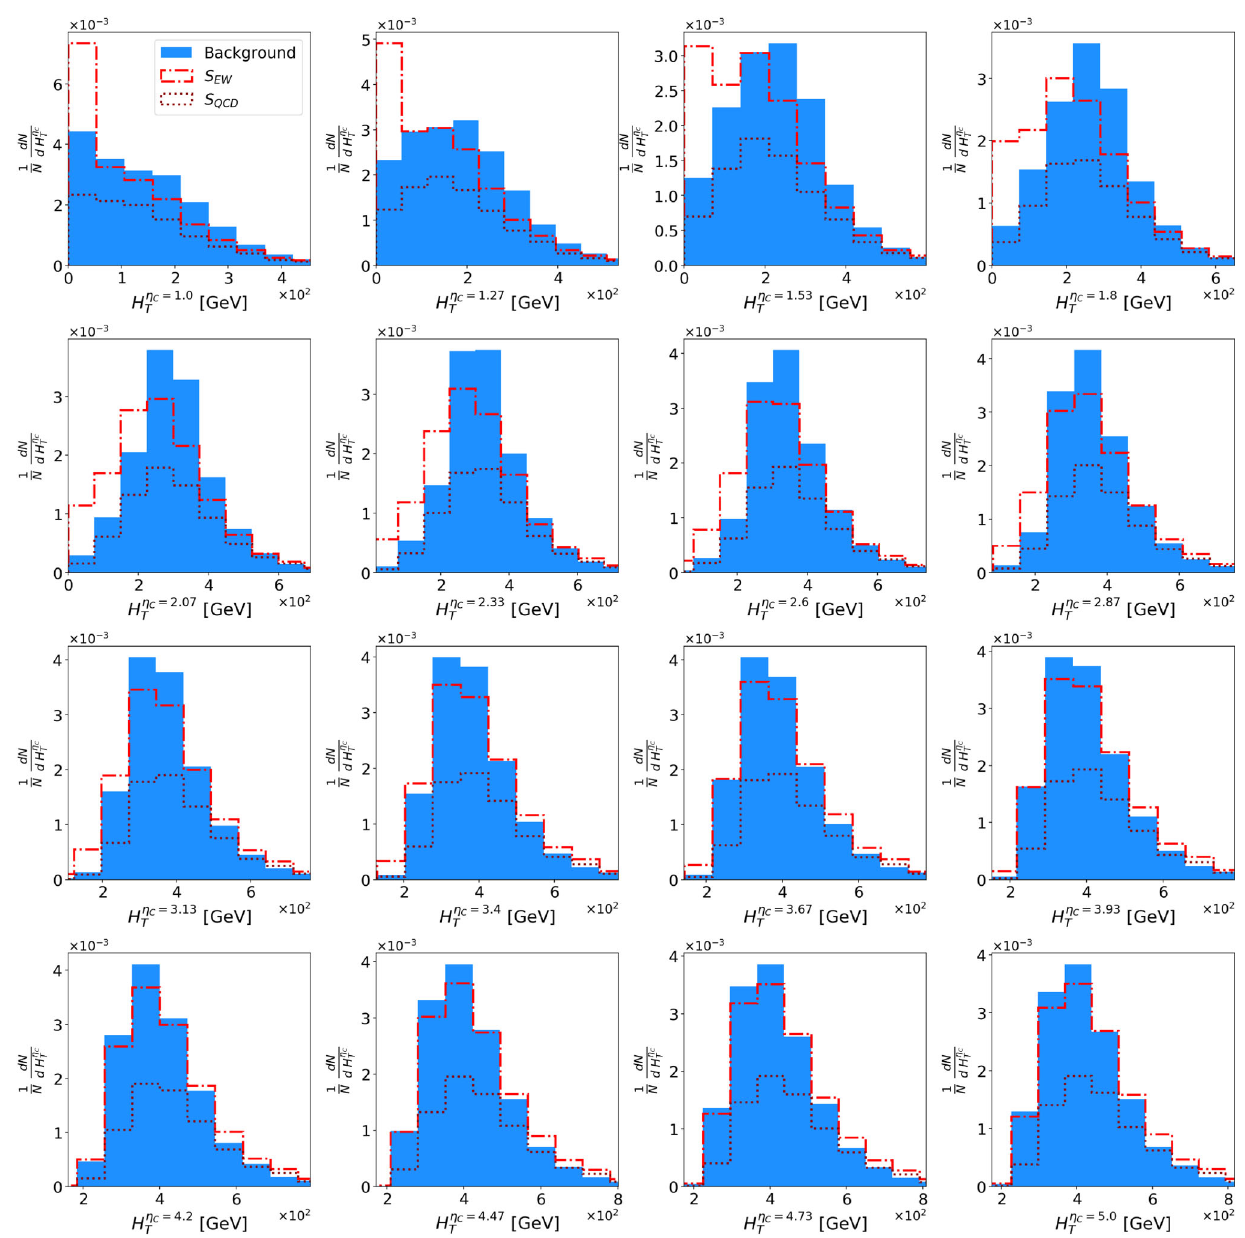
η C variables. We can see that for higher values of η C the signal and background are not that T